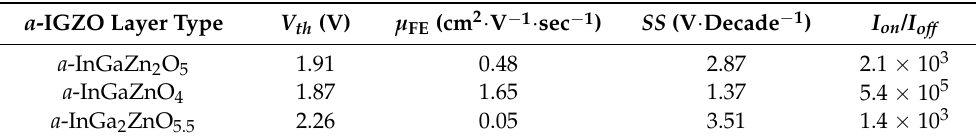
Figure 10. Output characteristics of TFT samples containing as-deposited ( a ) a -InGaZn 2 O 5 , ( b ) a - InGaZnO 4 , and ( c ) a -InGa 2 ZnO 5.5 active channel layers. Table 4. Transfer characteristics of the three types of TFT samples containing as-deposited a -IGZO active channel layers.